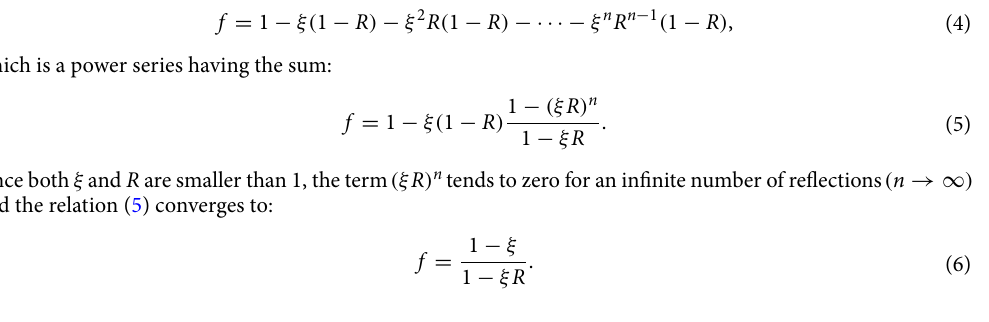
0 . Symbols correspond to MC simulations, full =